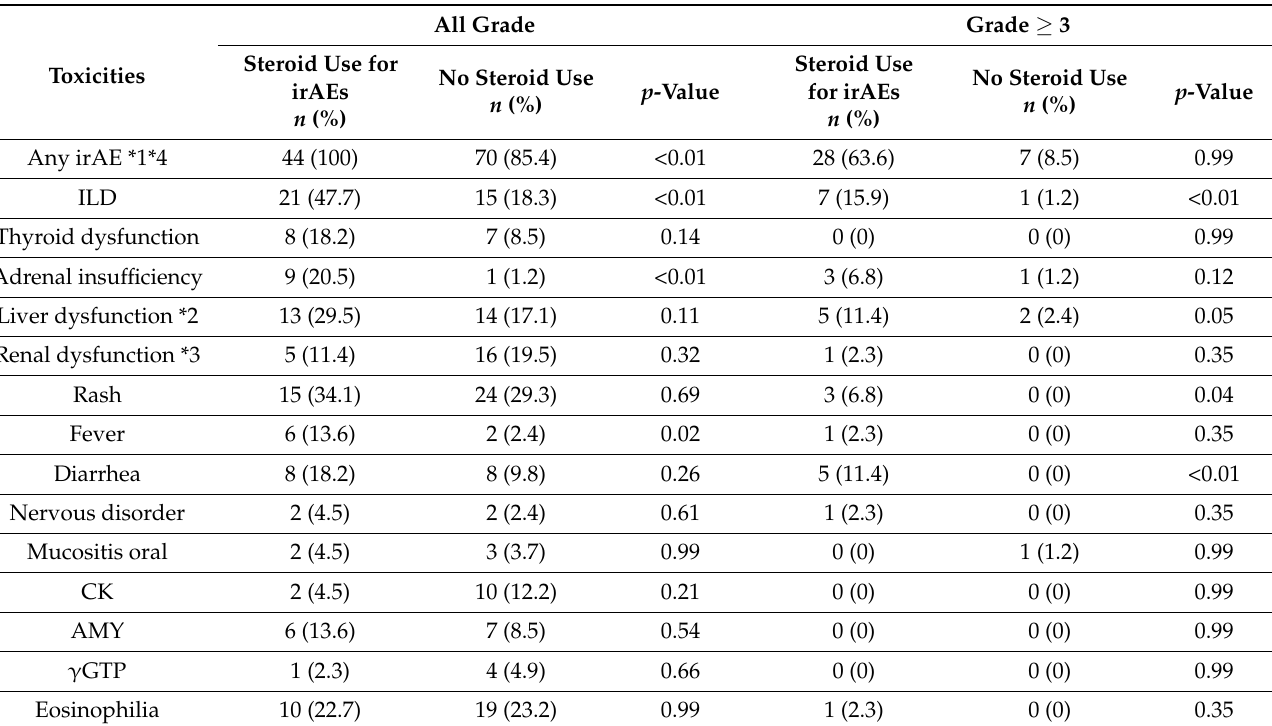
Table 3. Frequency of